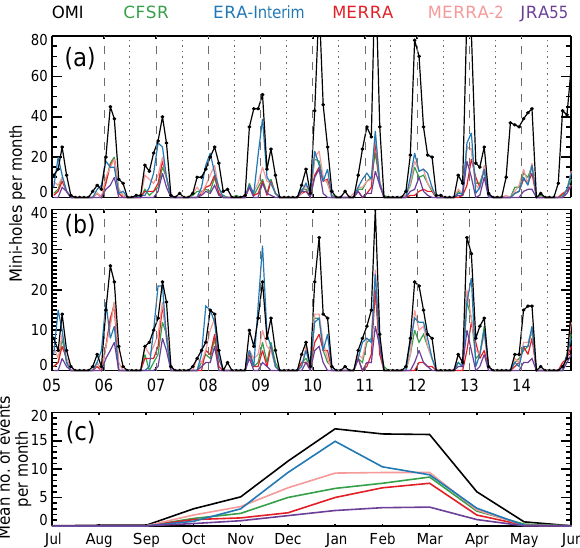
Figure 4. Mini-hole events per month during 2005–2014 in the Northern Hemisphere as found in OMI data and reanalysis fields (black, green, blue, red, pink, and purple lines represent OMI, CFSR, ERA-Interim, MERRA, MERRA-2, and JRA-55, respec- tively). Panel (a) shows all the events while (b) displays only the events with area greater than 200000km 2 . Dashed vertical lines in- dicate the beginning of each January; dotted vertical lines show the beginning of each July. Panel (c) shows the mean number of mini- hole events in a given month (during 2005–2014) for events with area greater than 200000km 2